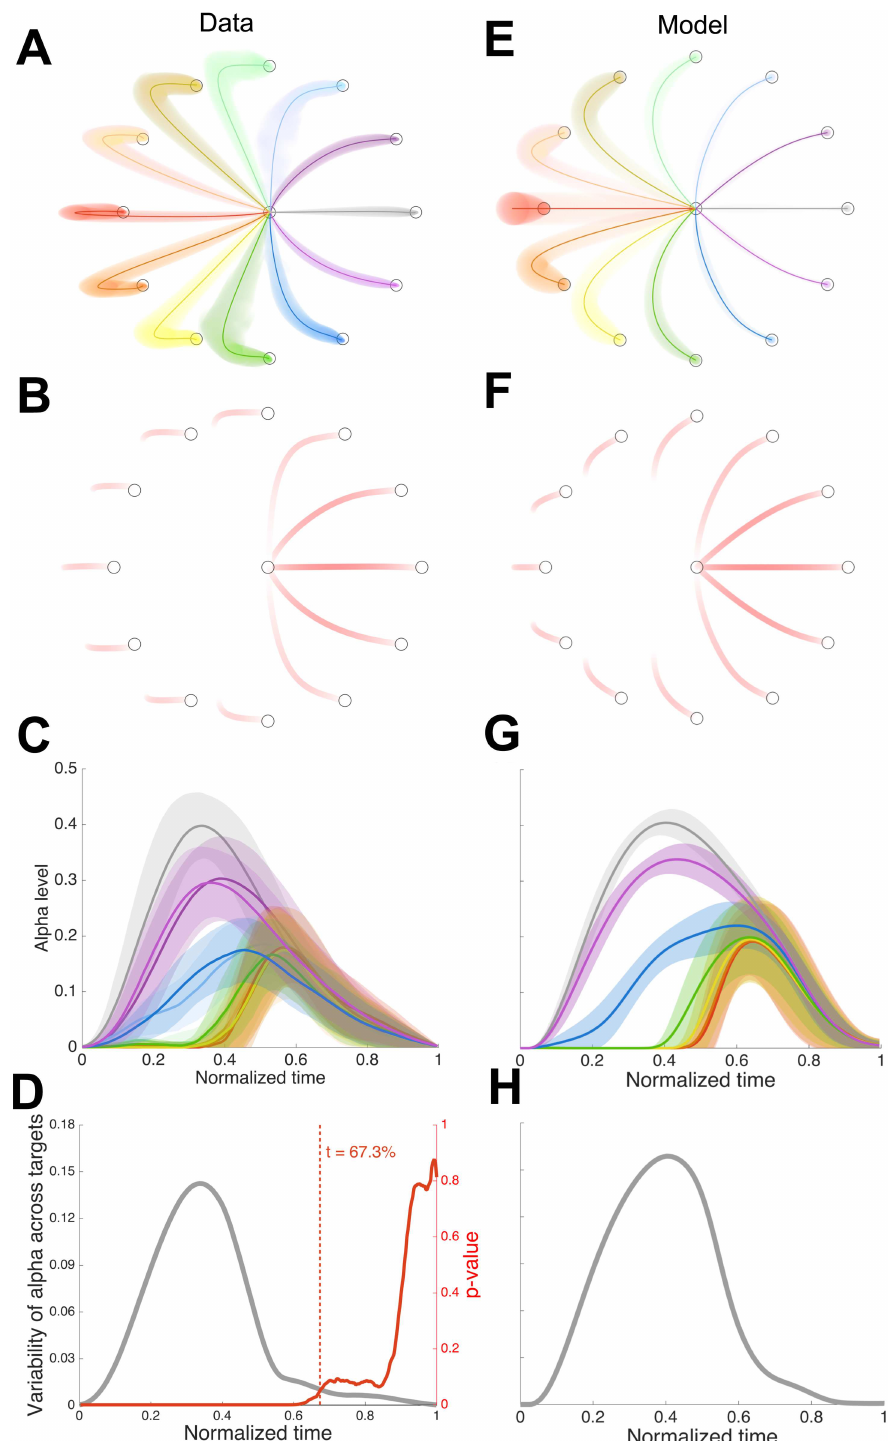
Fig 4. Empirical and simulated behavior in Experiment 1. (A) averagehand paths across subjects (mean ± s.d. across the subjects). (B) cursor visibilitycorrespondingto the averagehand trajectories in (A). (C) Alpha level (visibility) againstnormalized time for each movement direction(mean ± s.d. across the subjects). Colors as in (A). (D) Variance of alpha across the 12 target directions. Red line shows the p-value for the data based on an ANOVA across the 12 directions for each normalizedtime. The vertical red dashed line shows the last time p < 0.05.( E )-( H )same as (A)-(D) for the